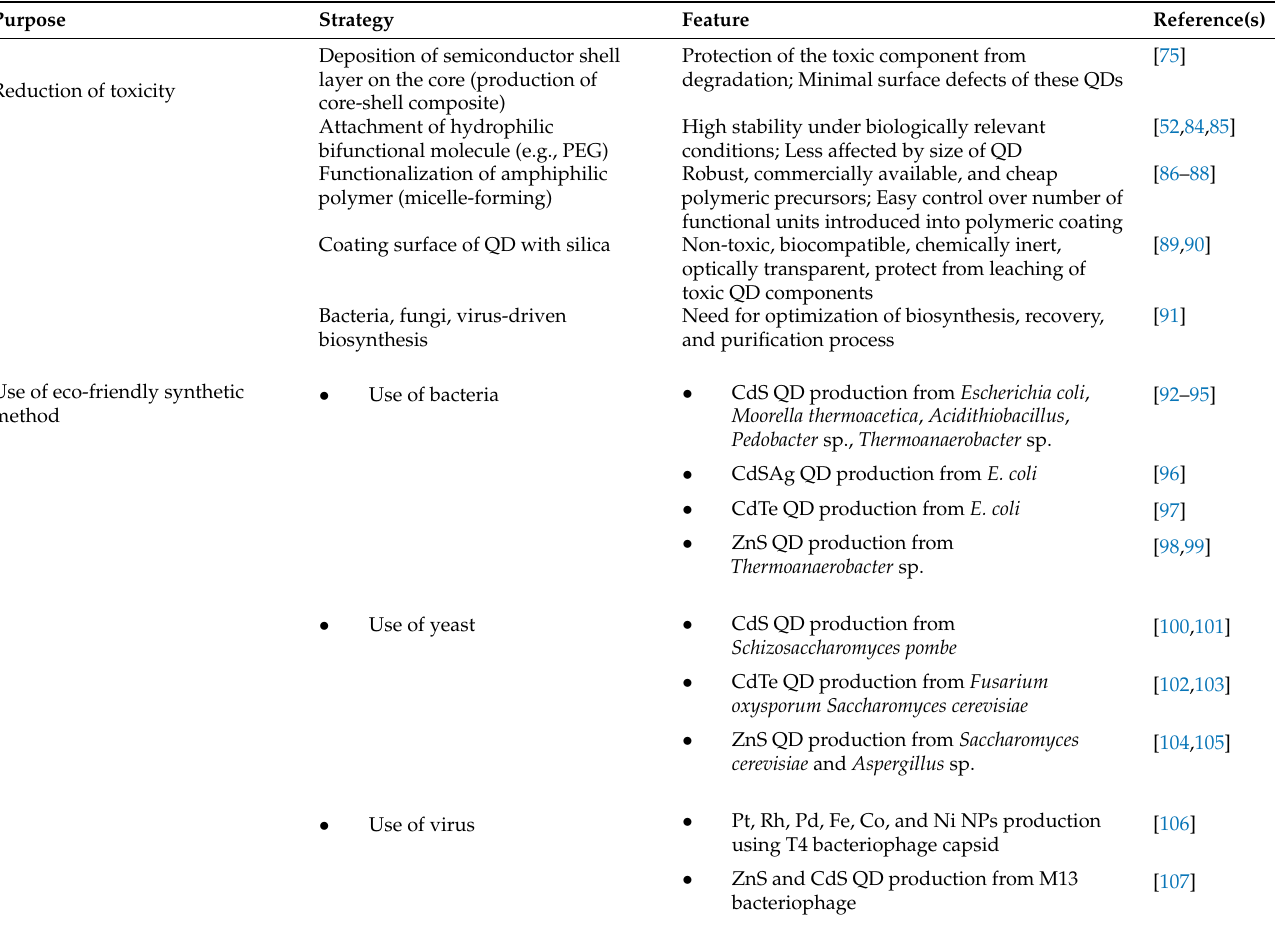
Table 2. Strategies for overcoming toxicity of